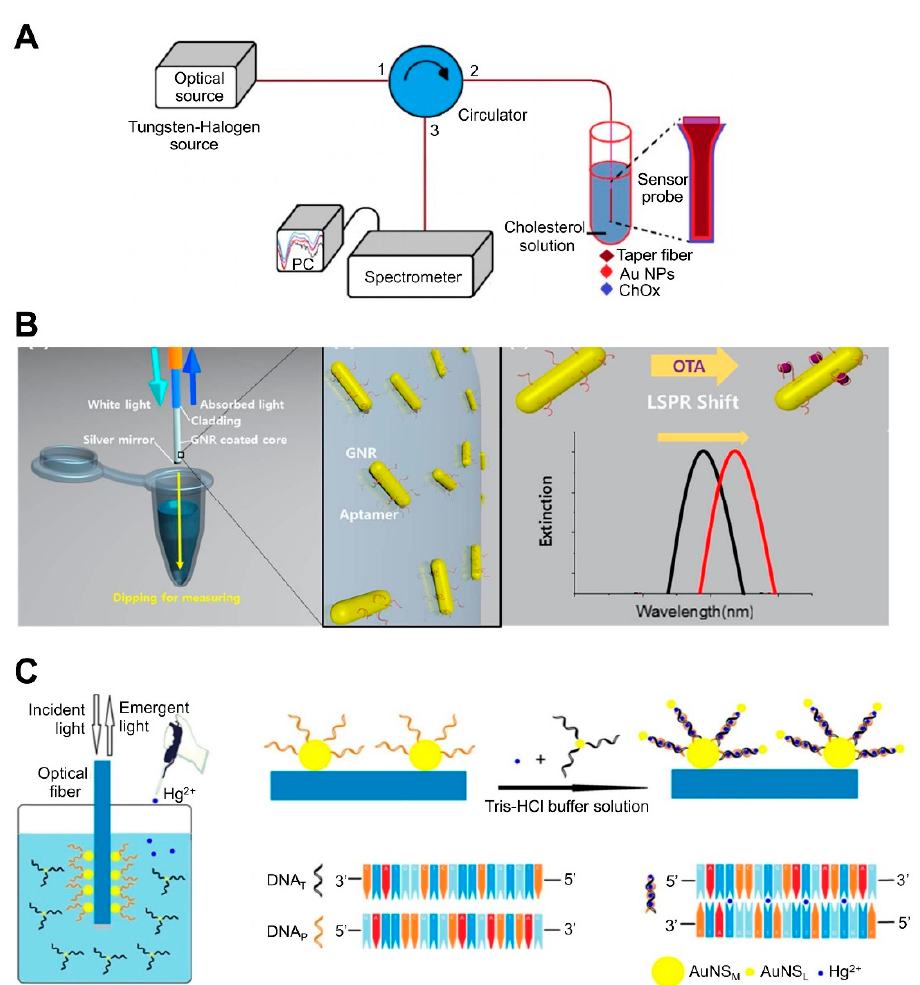
Figure 4. LSPR biosensing strategies based on nanoparticle (NP)-coated optical fibers: ( A ) Detection of cholesterol using cholesterol oxidase attached to an AuNP-immobilized fiber. Reproduced with permission from [85]; ( B ) Detection of ochratoxin A (OTA) using aptamer-modified gold nanorods (GNRs) immobilized on an optical fiber. Reproduced with permission from [74]; ( C ) Detection of Hg 2+ using optical fiber functionalized with Au nanospheres (AuNS) and a thiolated DNA probe. Reproduced with permission from [75].